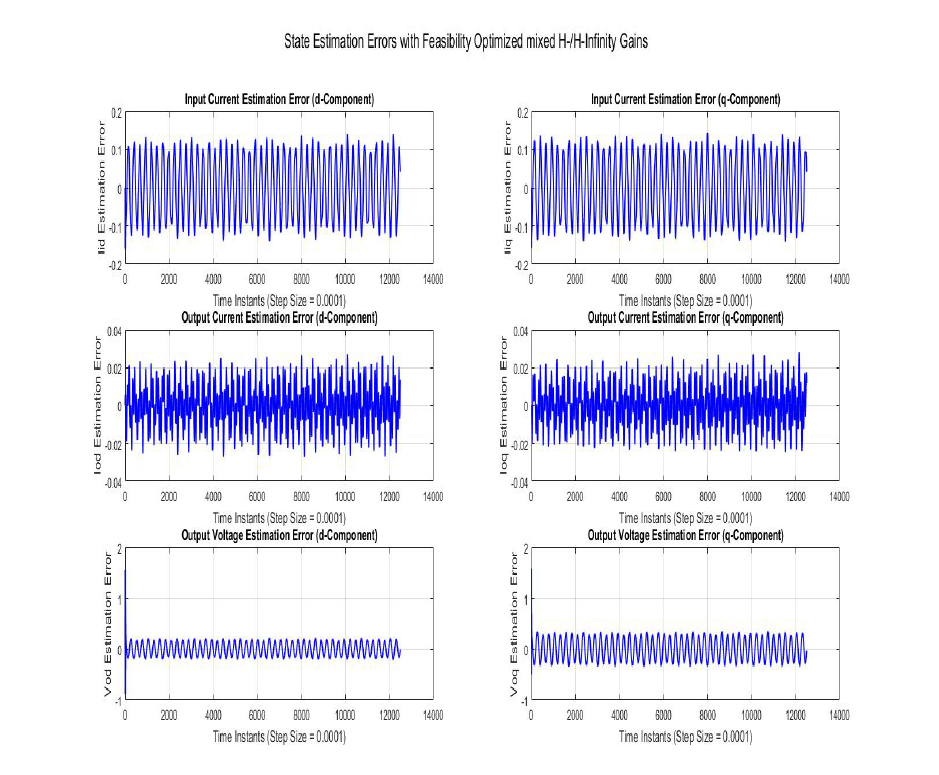
Figure 10. State estimation errors with feasibility optimized H − / H ∞